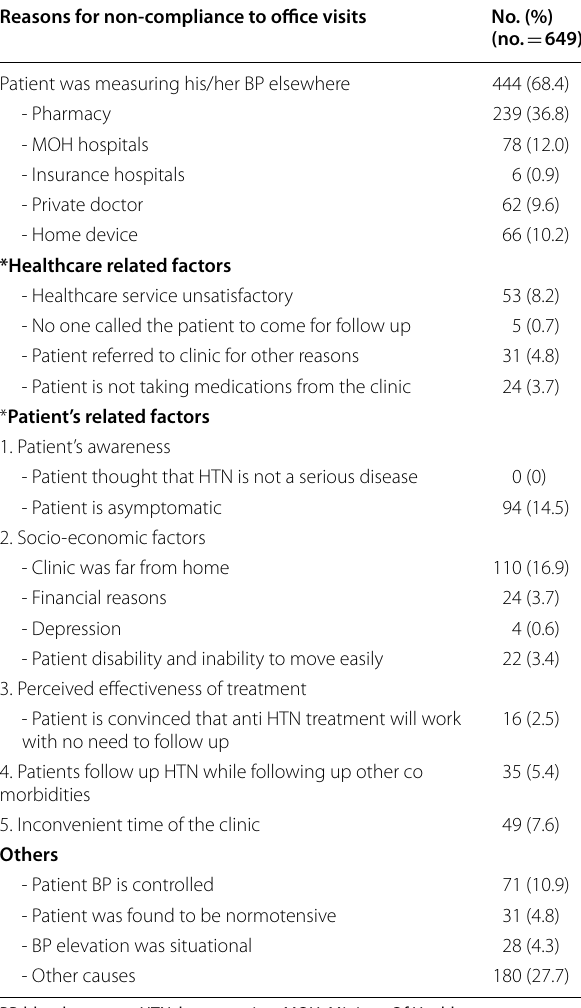
Table 3 Reasons why patients stopped coming for follow up in the HTN